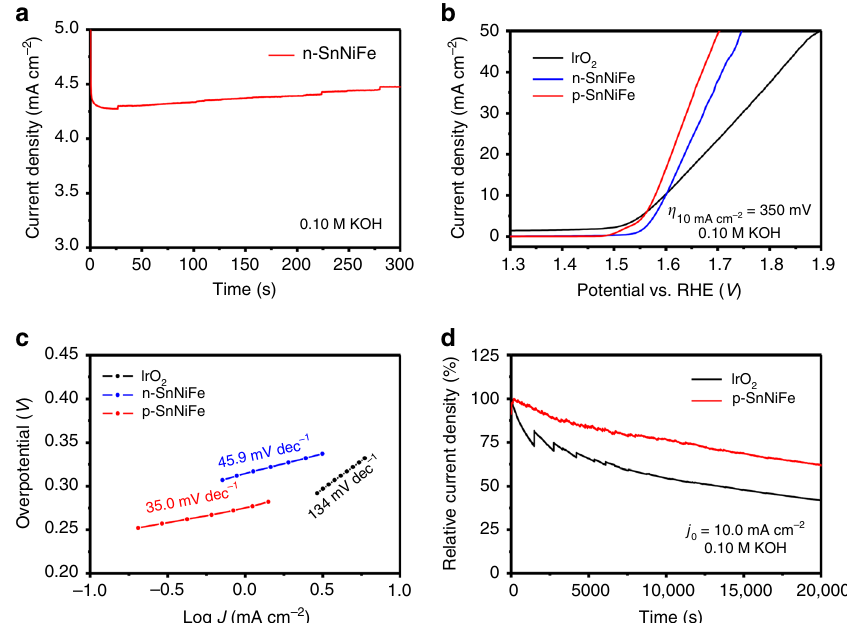
Fig. 3 Electrochemical activation and characterization of perovskite electrocatalysts for OER. a Electrochemical activation of n-SnNiFe perovskite at a constant voltage required to reach an initial current density of 5.0 mA cm − 2 in O 2 -saturated 0.10 M KOH. b 95% iR -compensated LSV pro fi les at a scan rate of 10.0 mV s − 1 and c Tafel plots of n-SnNiFe, p-SnNiFe, and IrO 2 . d Chronoamperometric response at a constant potential required for an initial current density of 10.0 mA cm − 2 of p-SnNiFe perovskite and IrO 2